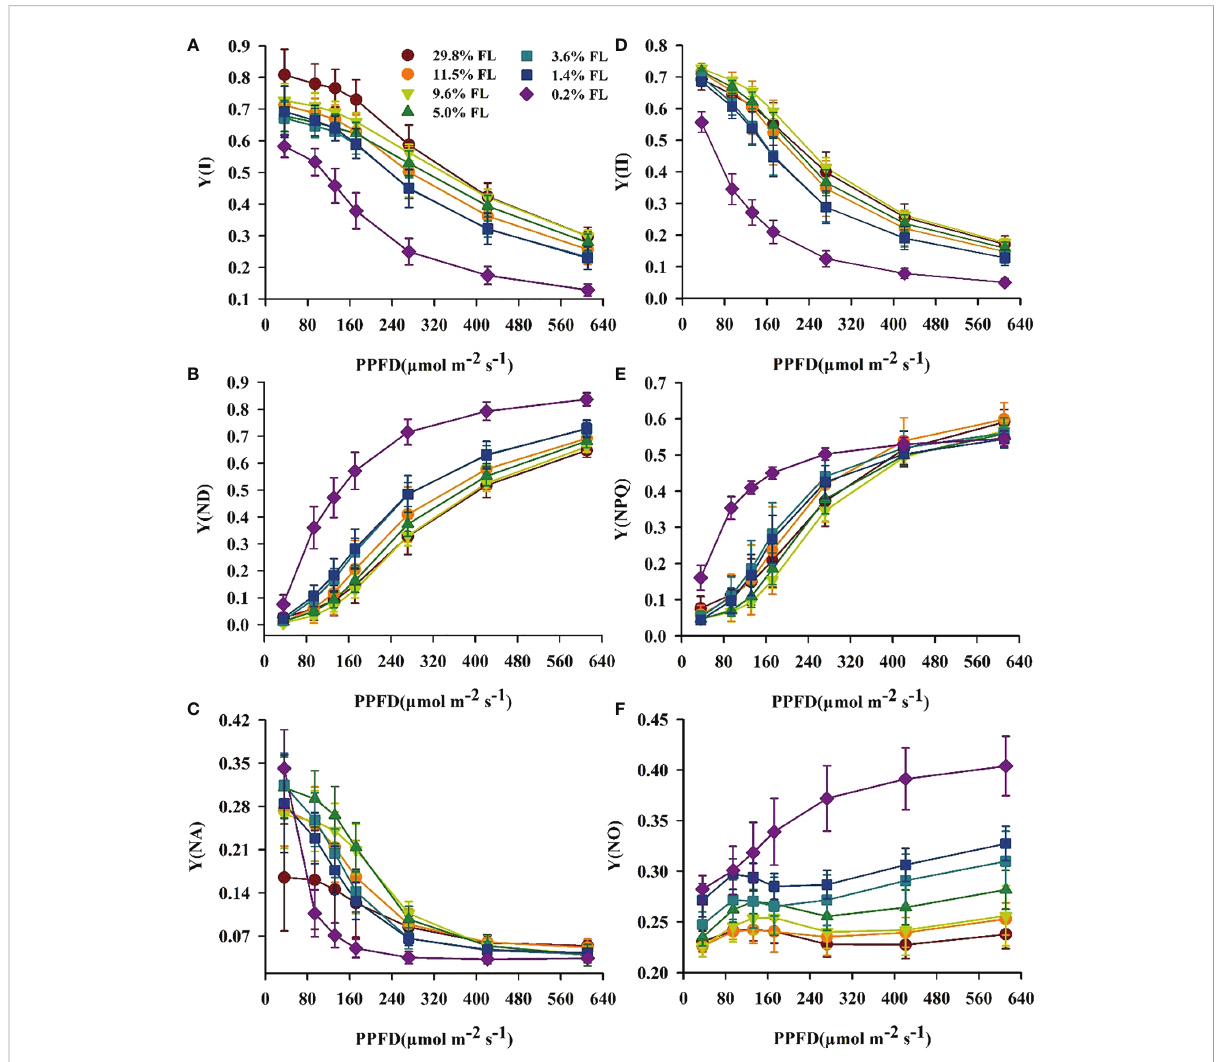
FIGURE 5 The effect of light regimes on light energy allocation in P. notoginseng . (A) Y(I) is the quantum yield of PSI. (B) Y(ND) is the donor side limitation of PSI. (C) Y(NA) is the acceptor side limitation of PSI. (D) Y(II) is the ef fi cient quantum yield of PSII. (E) Y(NPQ) is the yield of regulated energy dissipation of PSII. (F) Y(NO) is the yield of non-regulated energy dissipation of PSII. Values for each point were means ± SD ( n =